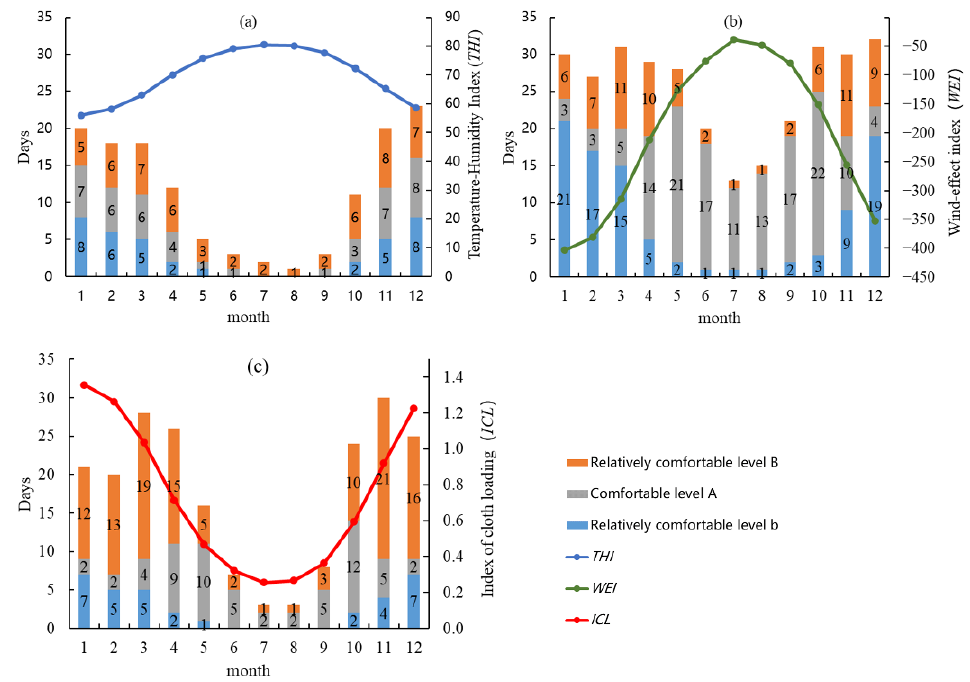
Figure 3. Monthly variation of comfort index and period of different grades from 1969 to 2018. ( a ): THI , ( b ): WEI , ( c ): ICL .